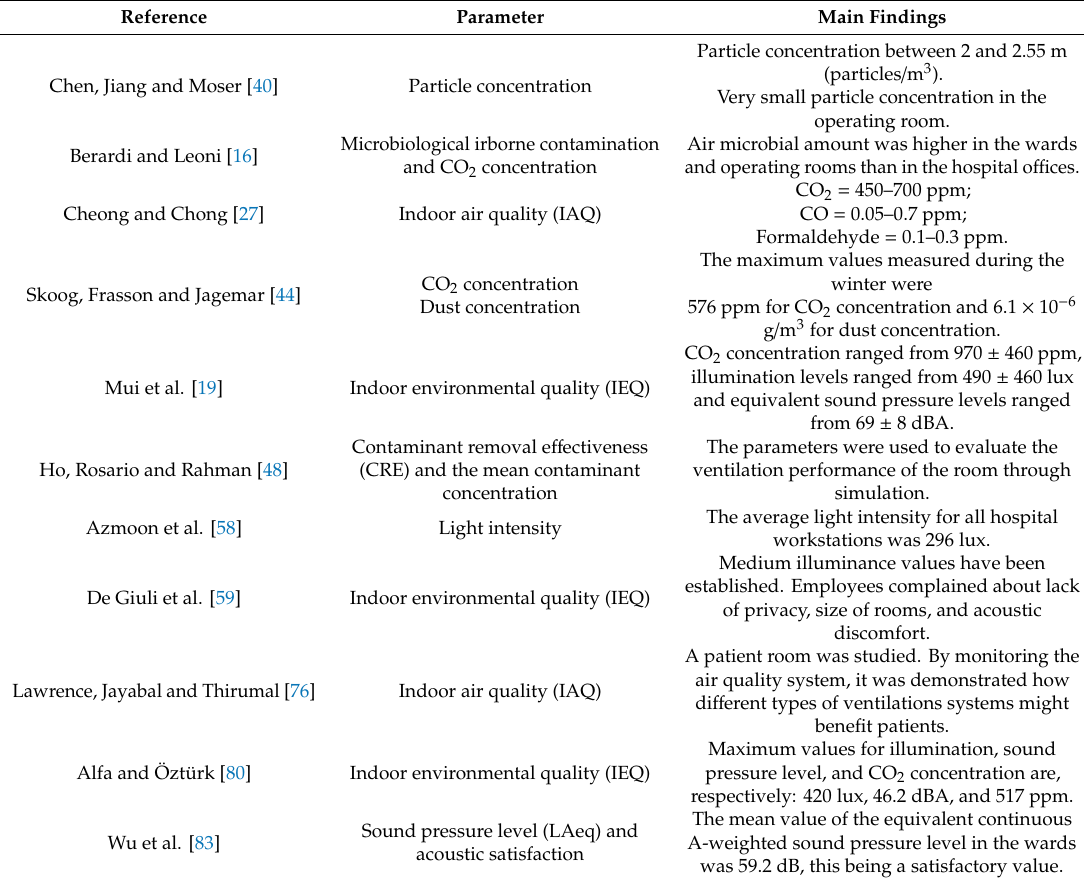
Table 10. Additional aspects evaluated in parallel to thermal